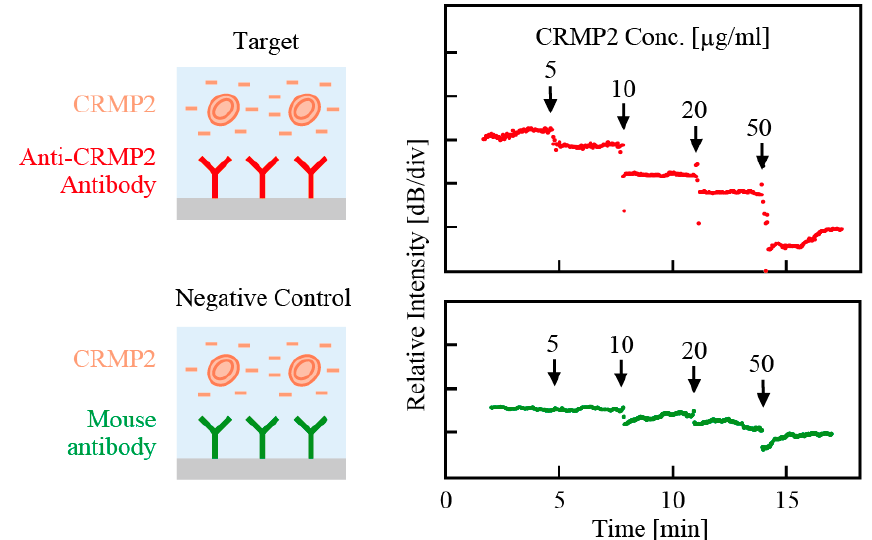
Figure 9. Change in emission intensity in nanolaser by the antigen-antibody reaction of CRMP2 protein which is negatively charged by SDS in advance.